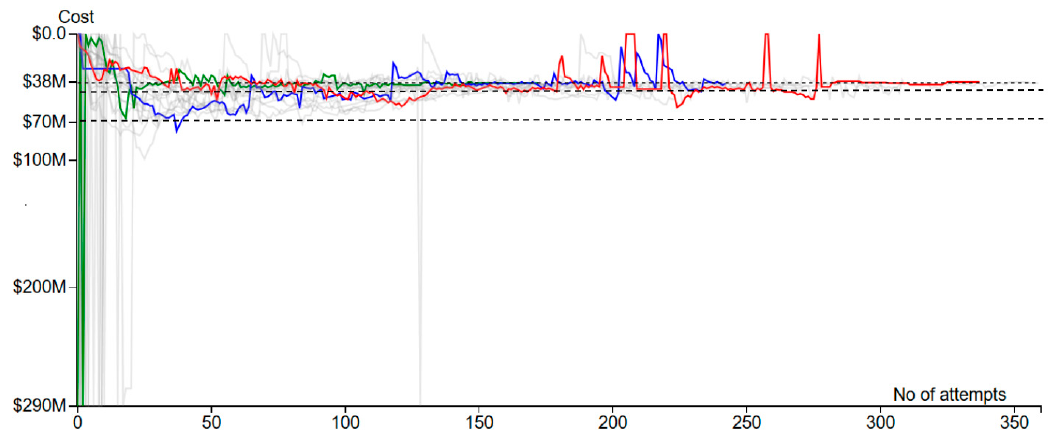
Figure 4. Convergence of players towards the optimal solution.